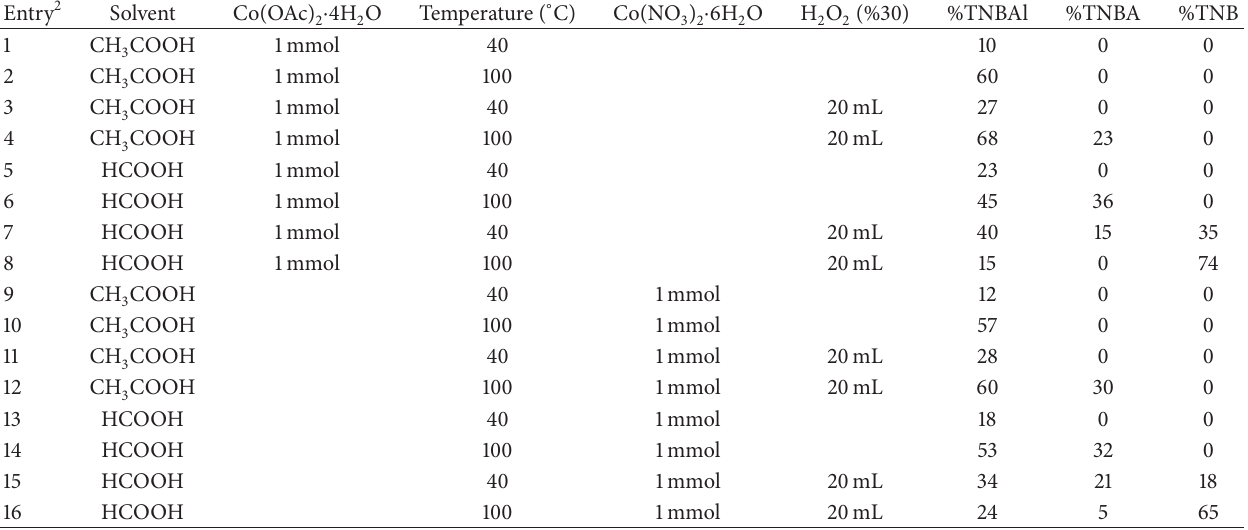
Table 1: The conditions and results of the oxidation of TNT.